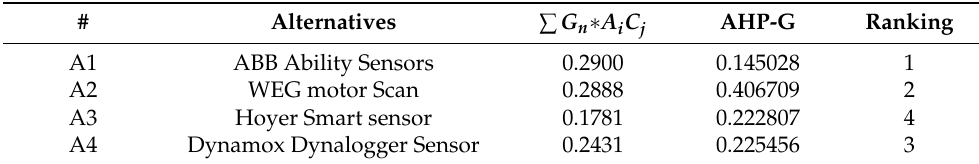
Table 10. Average criteria—standard deviation—Gaussian